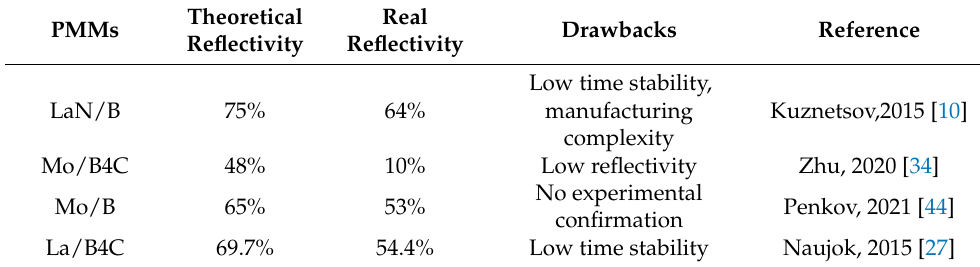
Figure 5. An analogy of the simulated peak reflectivity of varying PMM models at λ = 6.7 nm and 5° off normal angle of incidence: ideal Mo/B multilayer; Mo/B multilayer with interface roughness; real Mo/B multilayer with interlayers. Reprinted from [44] with permission from Elsevier. Table 1. Reported reflectivity of various PMMs for BEUV